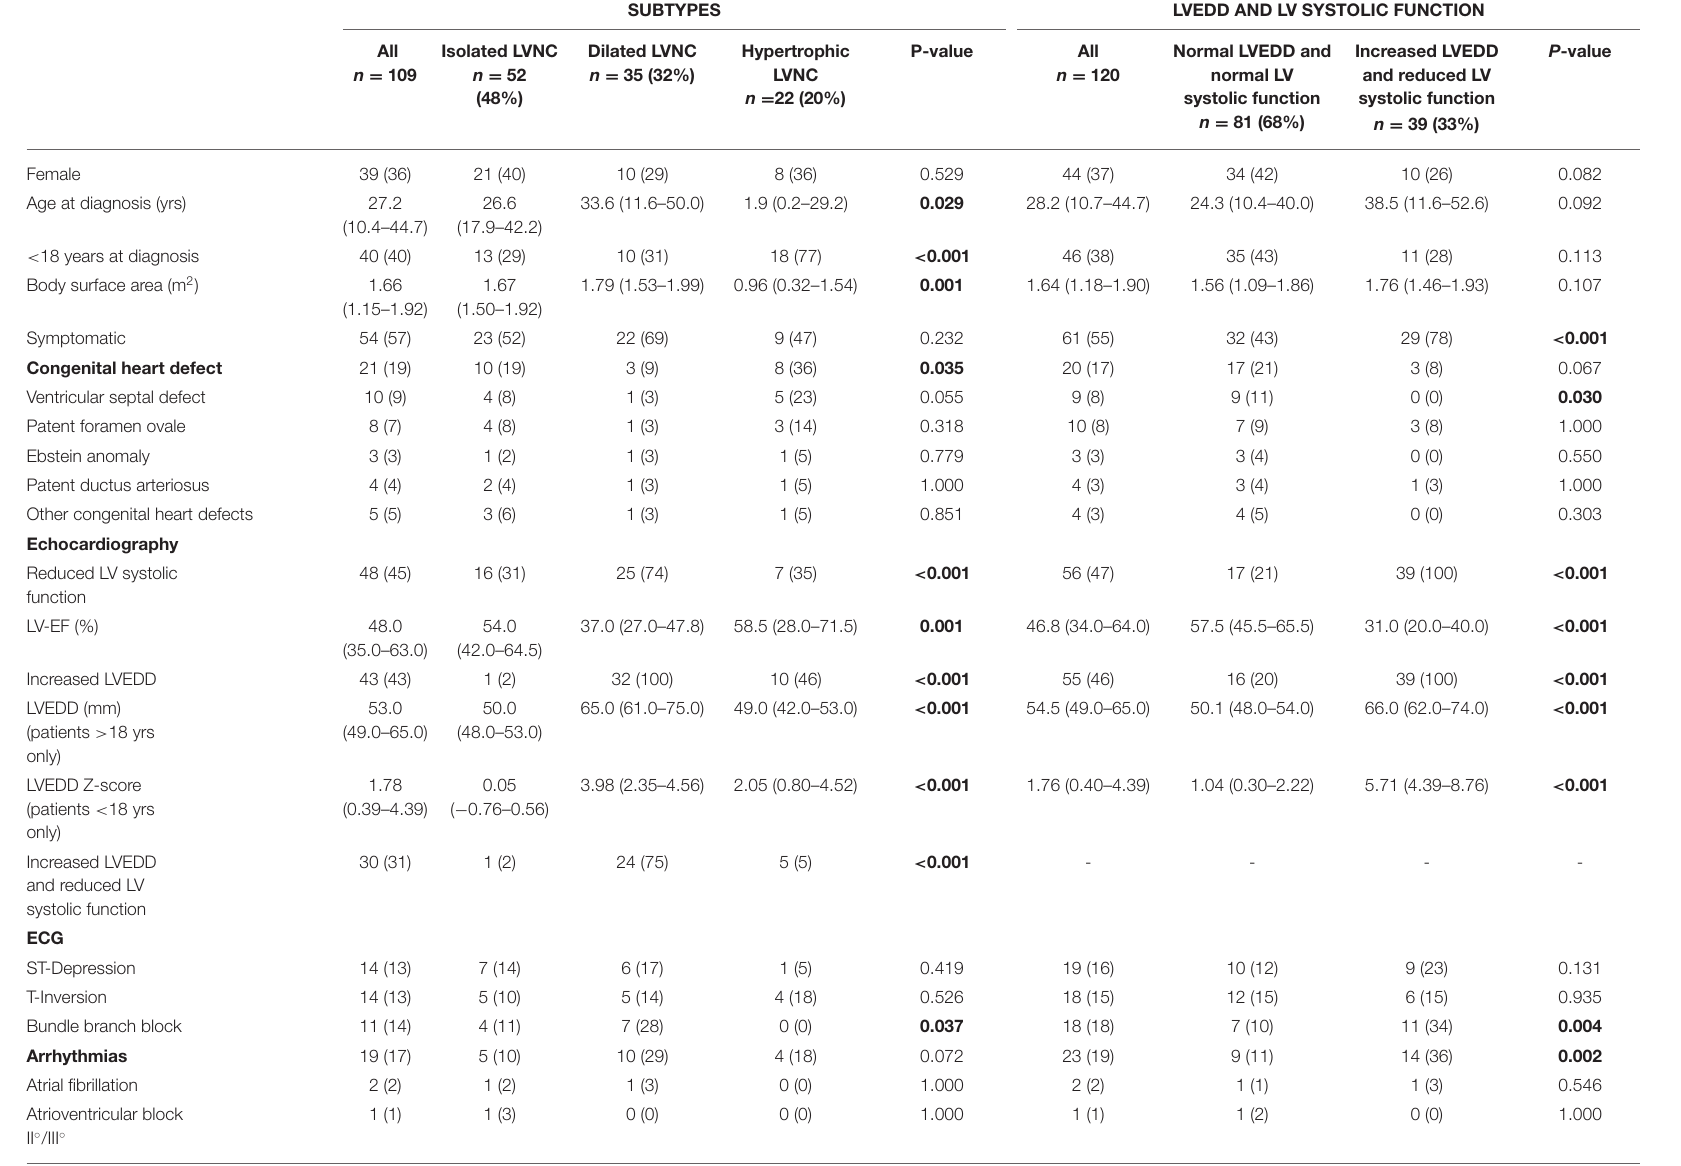
TABLE 3 | LVNC subtypes and echocardiographic